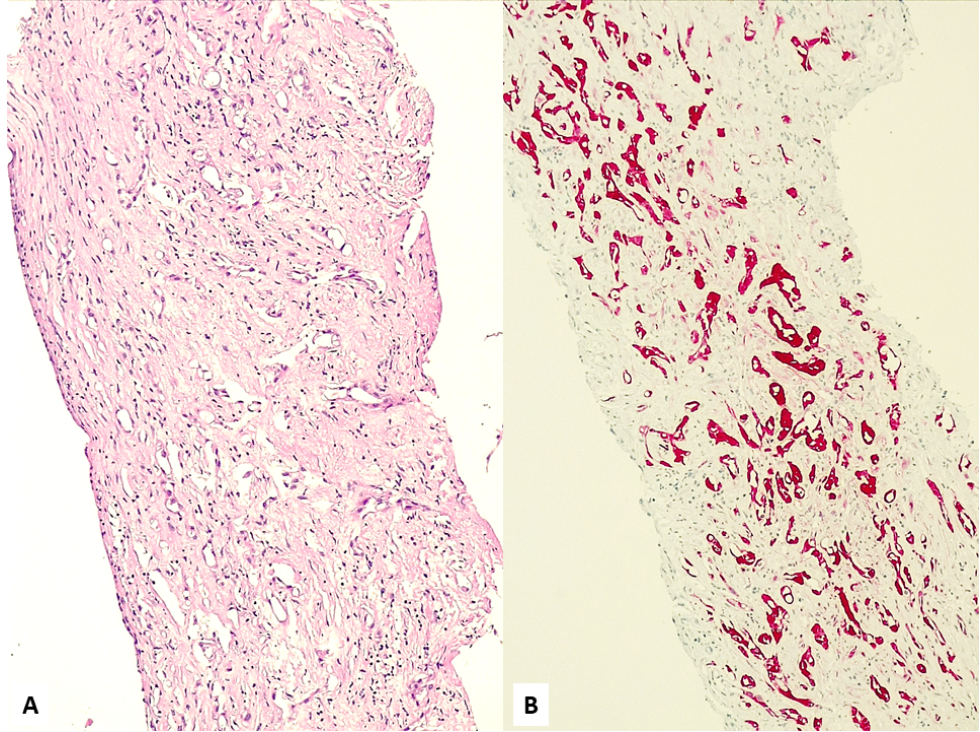
Figure 8. An unusual case of epithelioid mesothelioma with bland-looking adenomatoid-like spaces ( A ) diffusely expressing calretinin ( B ).